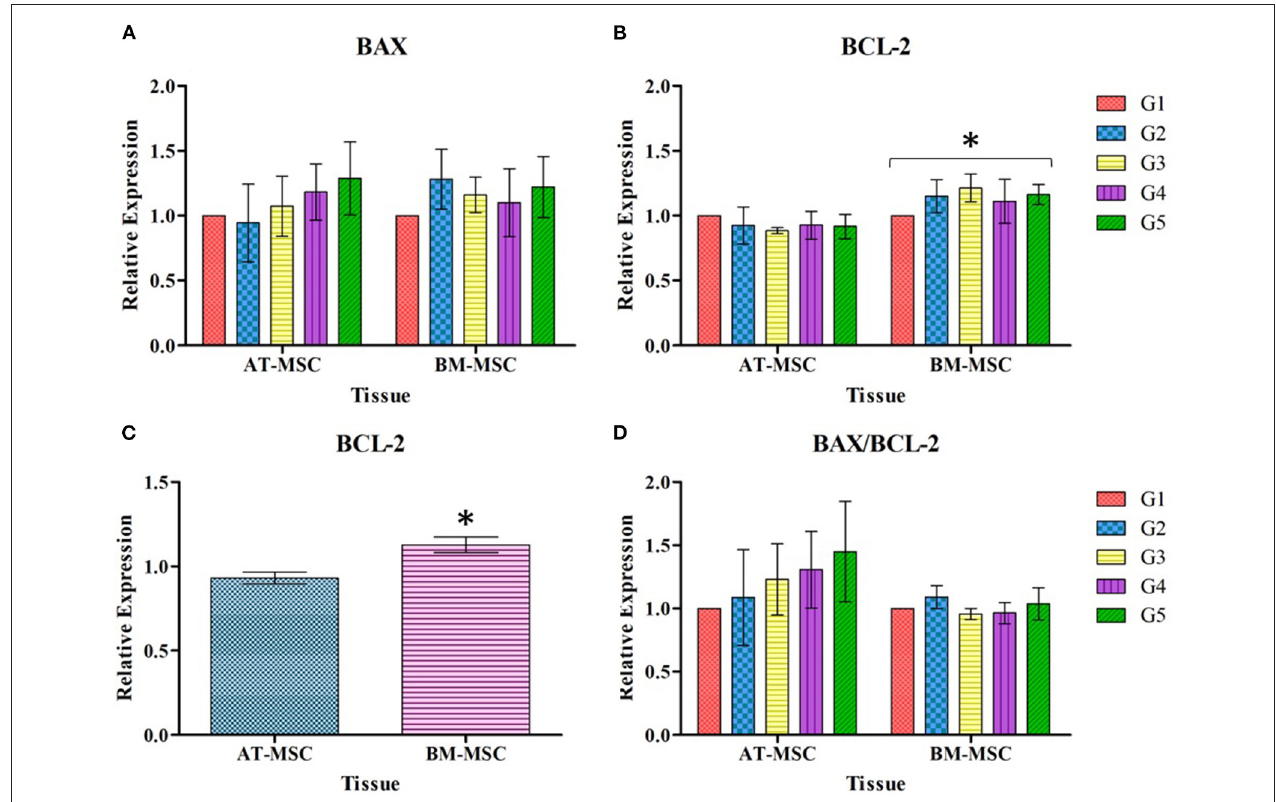
FIGURE 6 | Mean ± SEM relative expression of genes BAX (A) , BCL-2 (B) , BCL-2 grouped by tissue (C) , and BAX/BCL-2 expressed as ratio (D) , in AT-MSC and BM-MSC exposed to cryoprotectant solutions for 30min. *Significant statistical differences ( P < 0.01) among the tissues